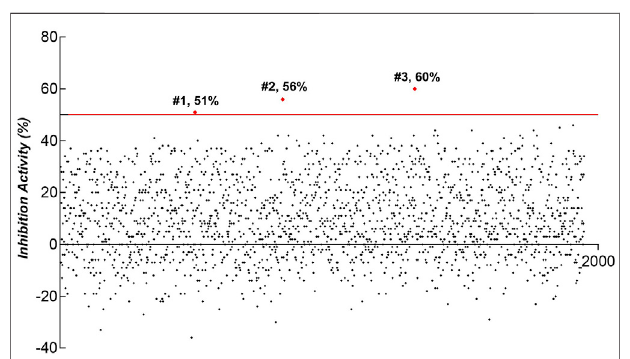
FIGURE 3 | ICW-based assay screen of natural products for the compounds that inhibit LINE-1 ORF1p expression in T47D cells.